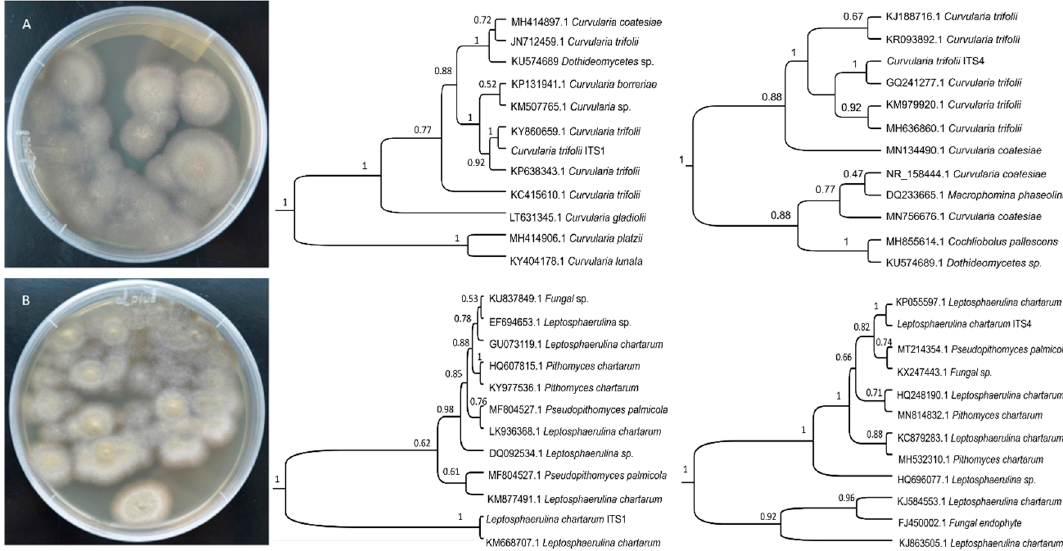
Figure 1. The cultural morphology of C. trifolii ( A ) and L. chartarum ( B ), and their phylogenetic relationships on the basis of ITS regions. relationships on the basis of ITS